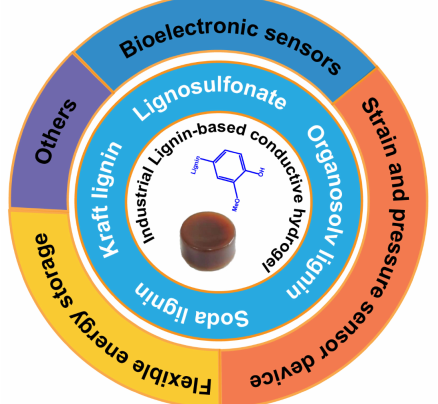
Figure 1. Schematic illustration of conductive hydrogels from different kinds of industrial lignin in different application